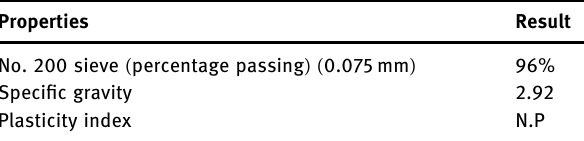
Table 5: Physical characteristics of limestone dust